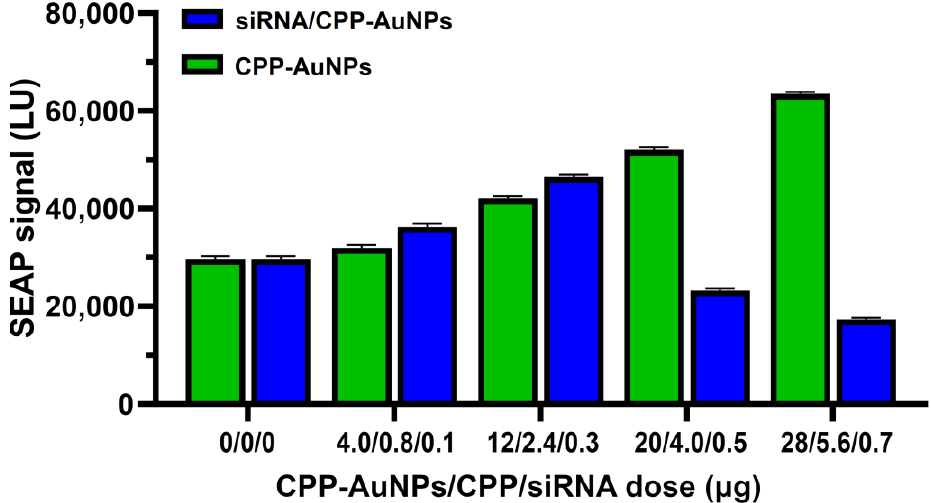
Figure 4. The mean SEAP secretion levels ( ± SD, n = 7) in SEAP-ARPE-19 cells, measured 24 h after treatment with siRNA/CPP-AuNPs and CPP-AuNPs. For statistical analysis, see Table S2.